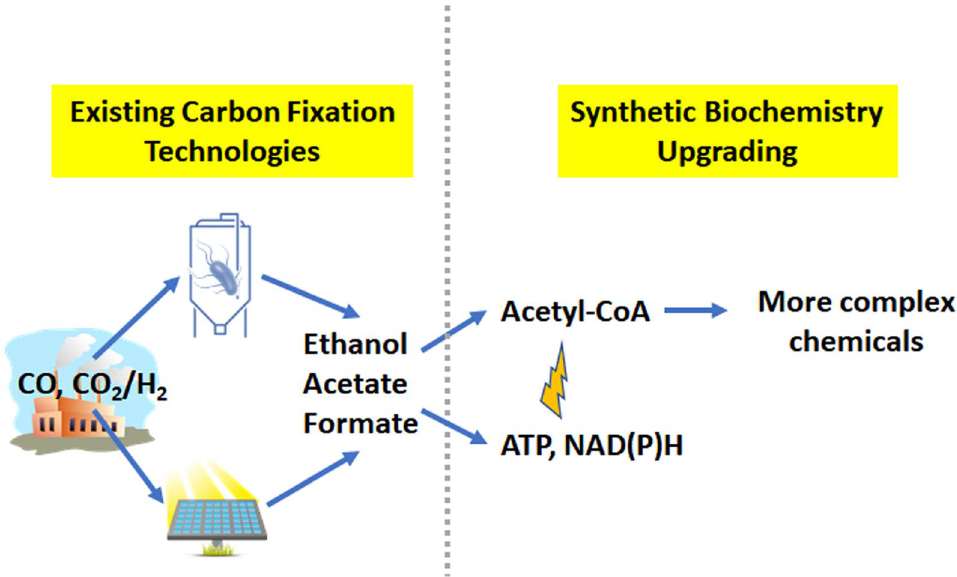
Figure 1. A possible path to a carbon negative chemical industry. Carbon is first fixed from the atmosphere into simple carbon compounds like ethanol and acetate using acetogens or electrochemistry.